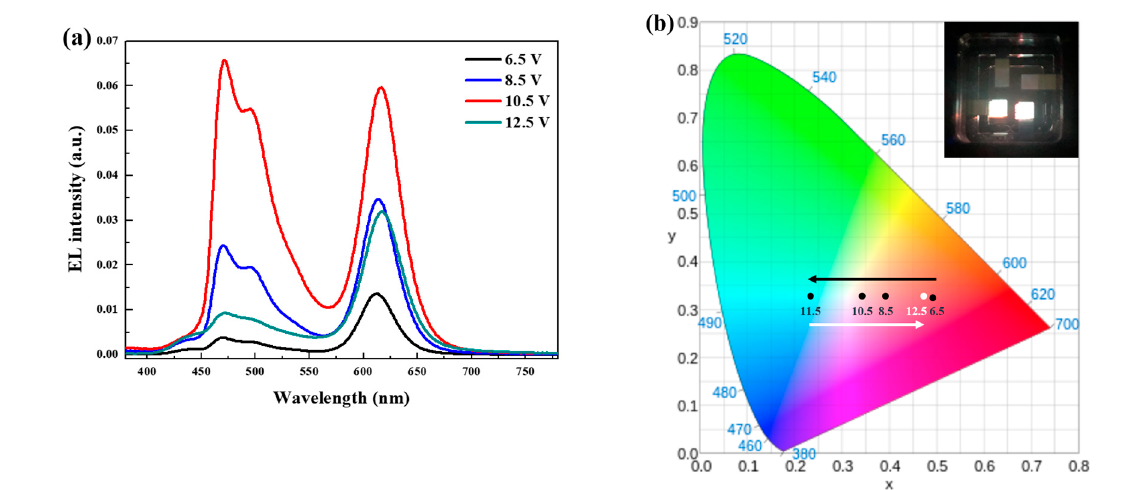
Figure 5. Voltage-dependent ( a ) EL spectra and ( b ) Commission Internationale de l’Eclairage (CIE) coordinates of hybrid QLEDs with double EMLs. The inset shows the white emission from 2.5 mm × 2.5 mm pixels at 10.5 V.